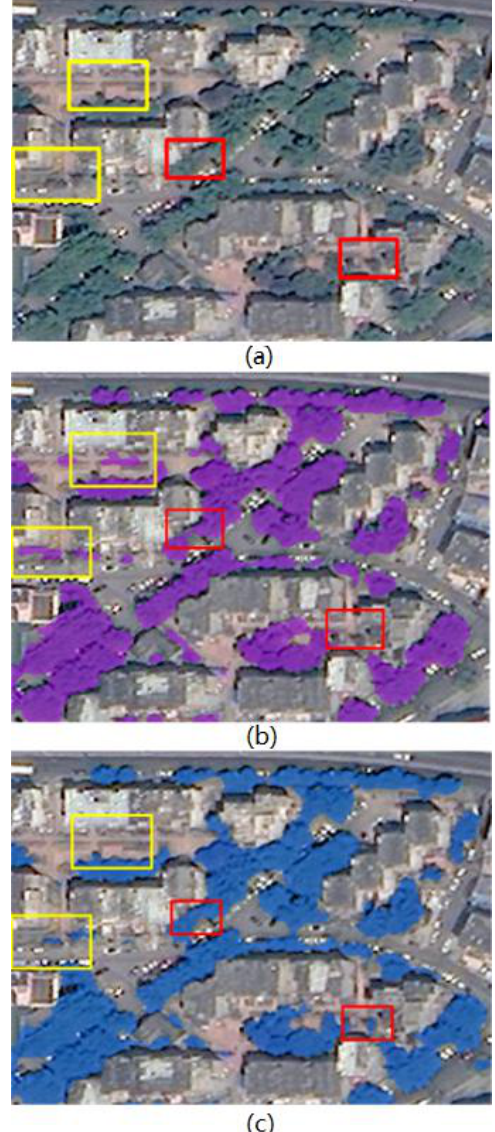
Figure 7. Comparison of greenery extraction results between the proposed method and NDVI